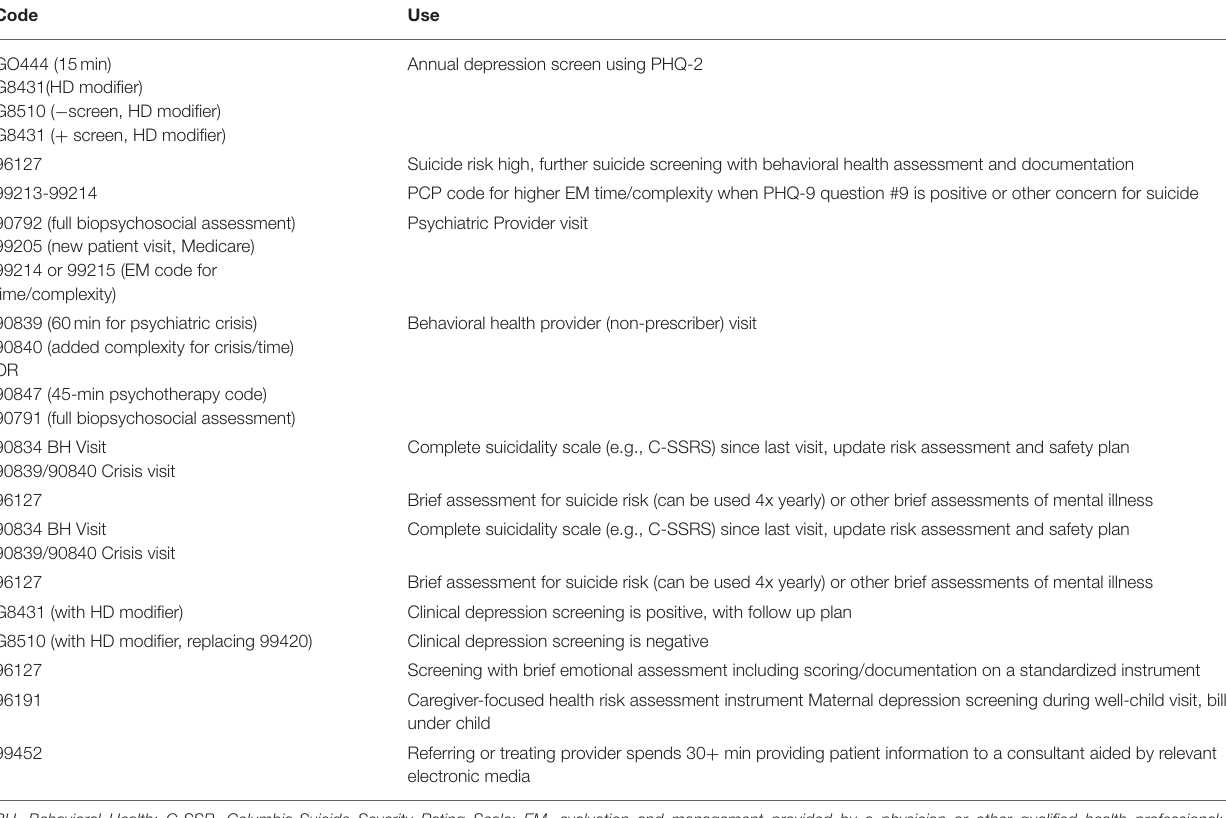
TABLE 2 | United States reimbursement codes for any behavioral health integrated level.